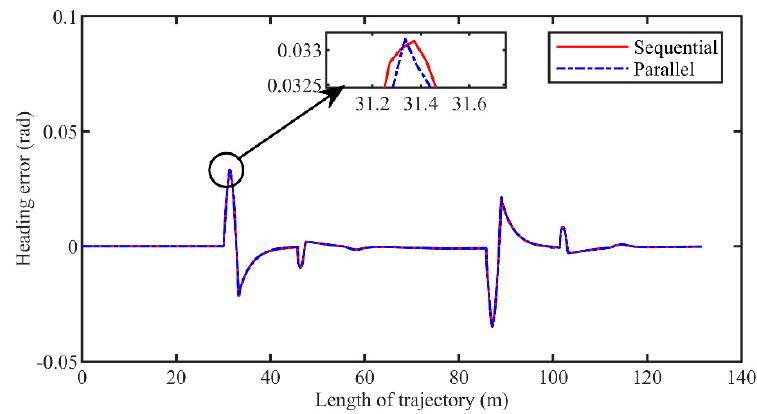
Figure 16. Heading error of the comparison between calculation processes.